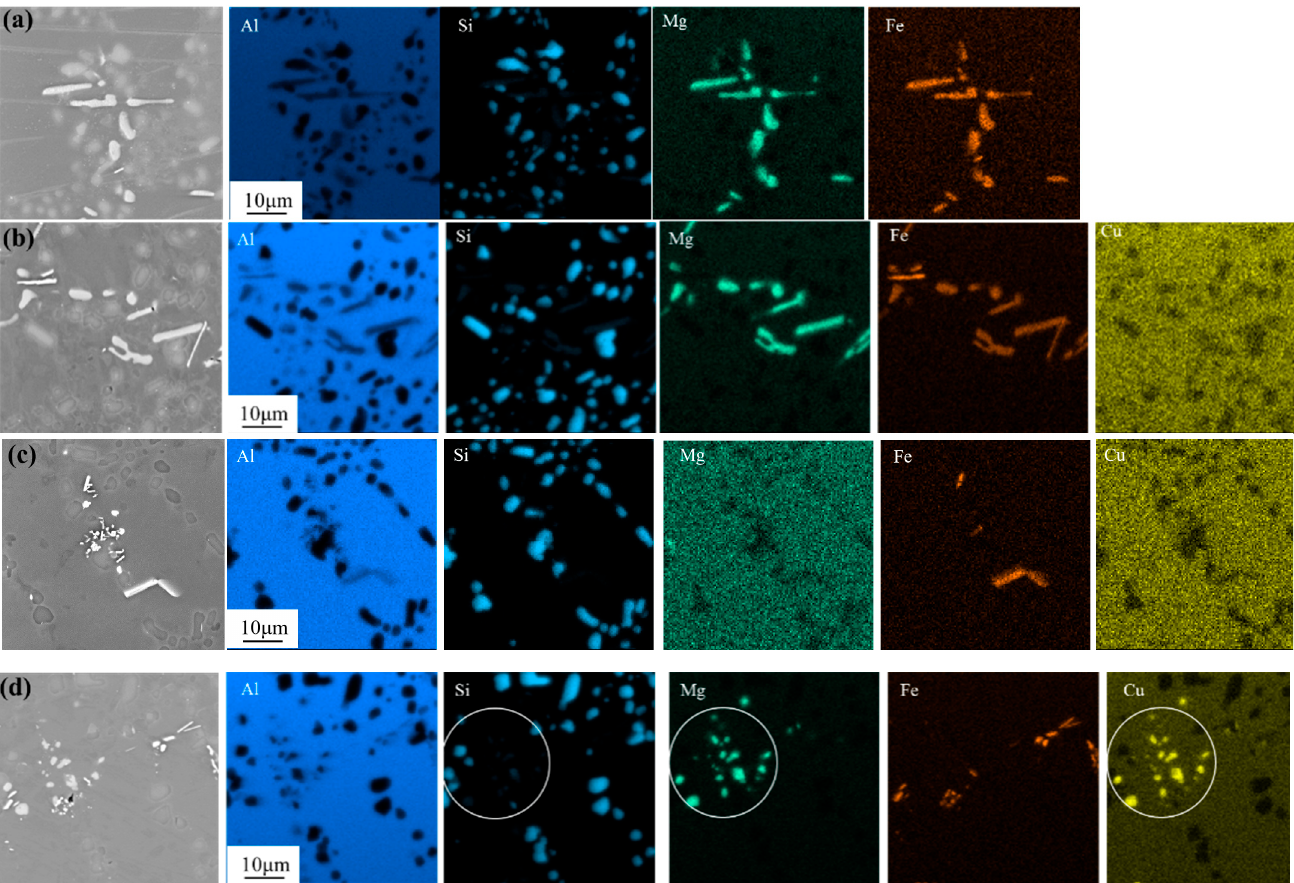
Figure 4. SEM-mapping images of the alloys after aging treatment ( a ) A1, ( b ) A2, ( c ) A3, ( d )